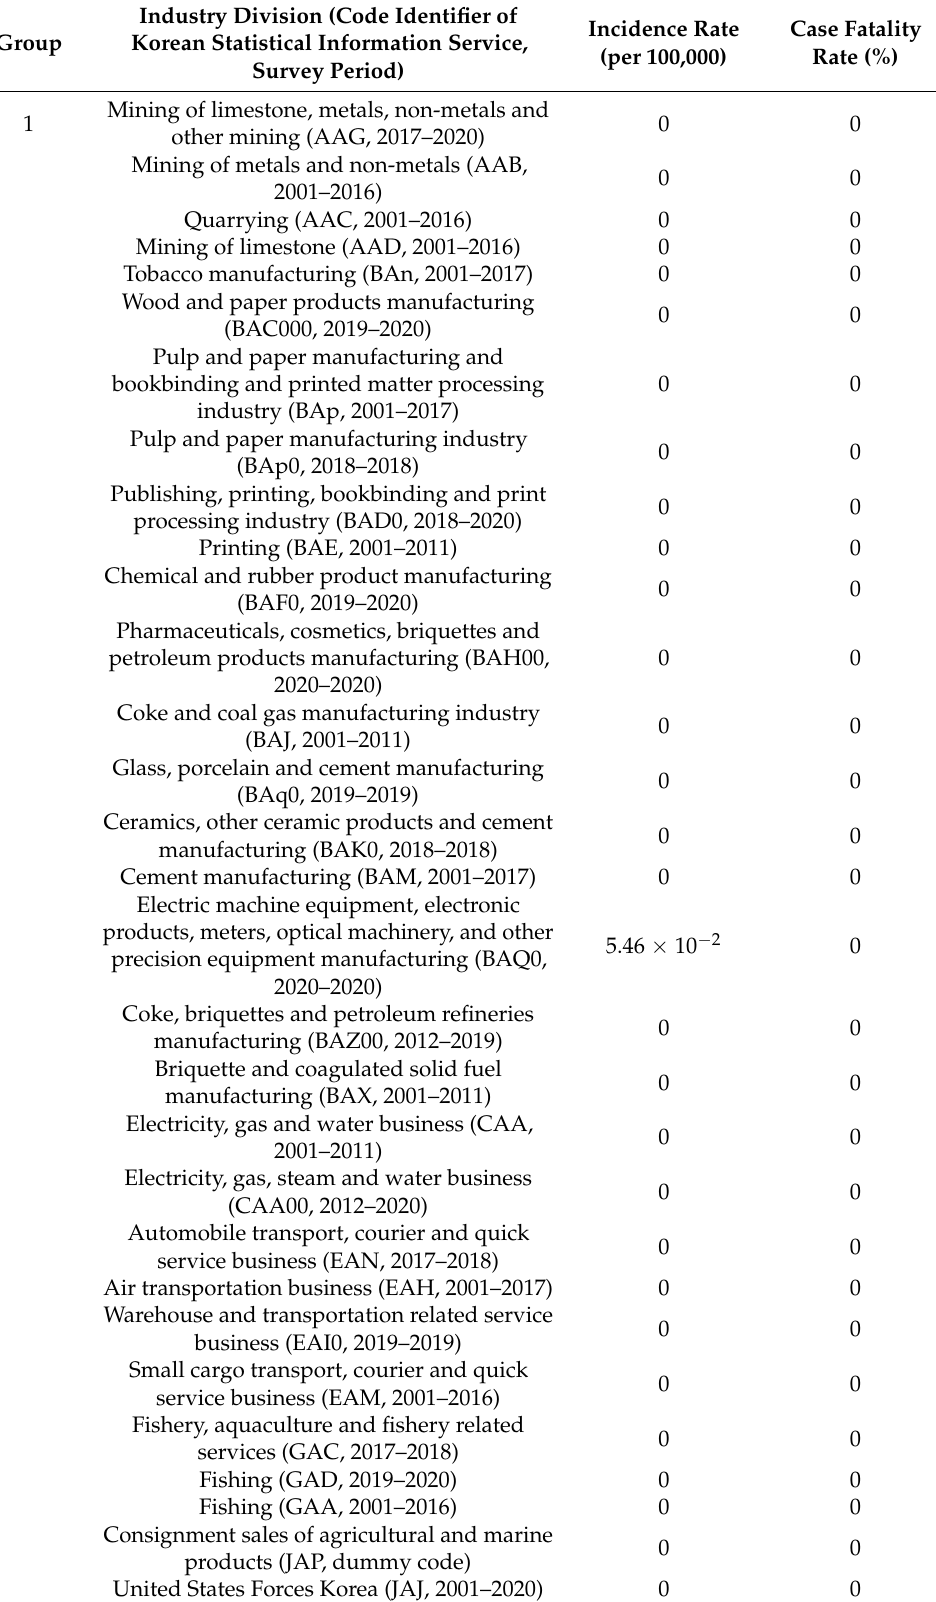
Table 6. Industry division by risk group and the incidence and fatality rates by industry division.